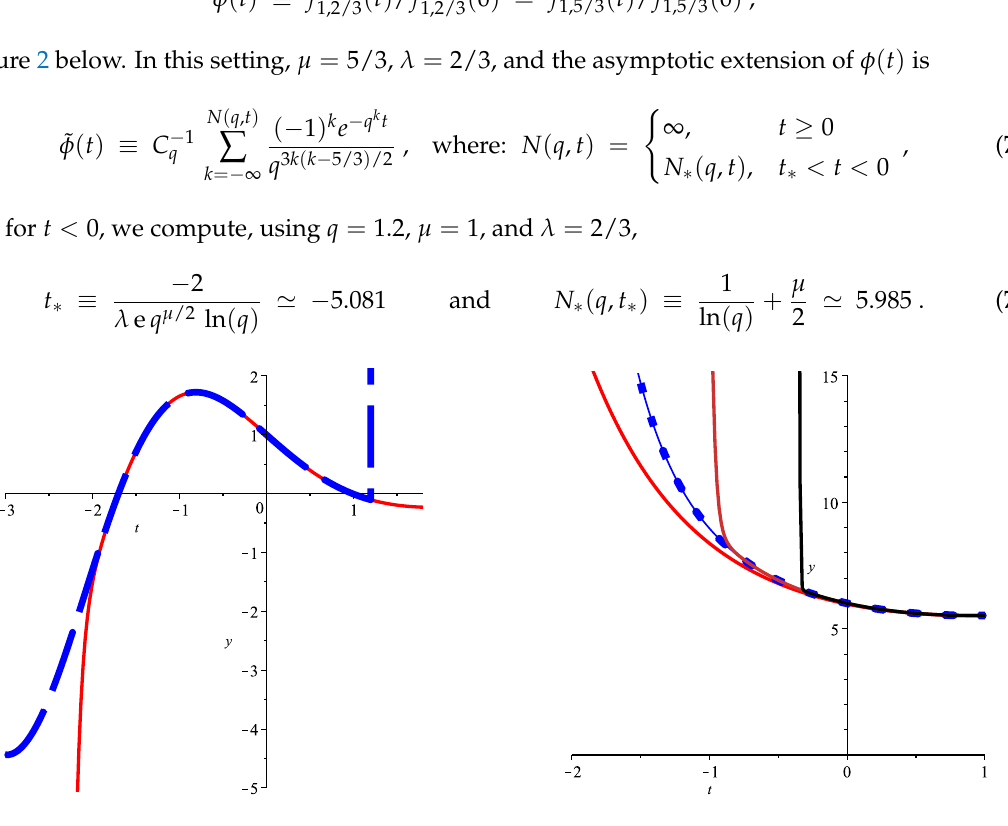
( 0 ) (dashed blue) both for 1,2/3